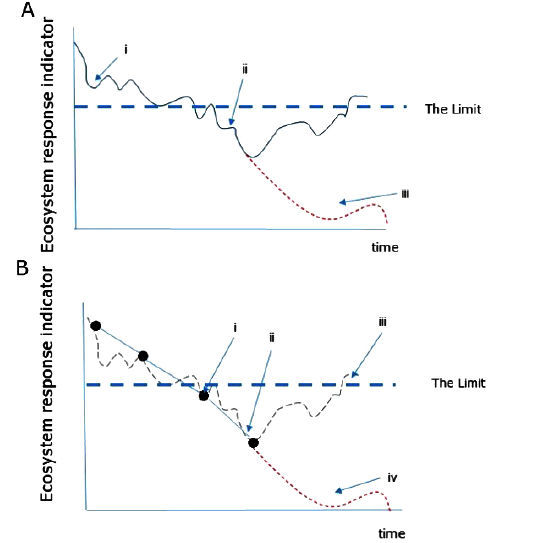
Fig. 2 . Implications for science-governance-society of